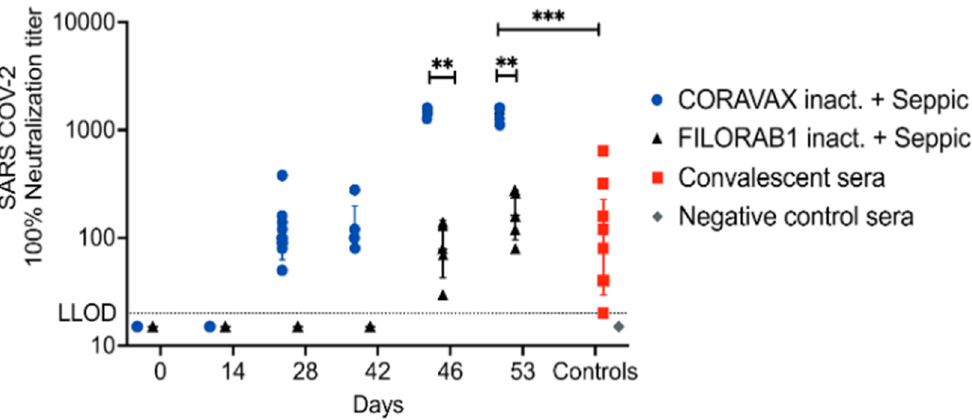
Figure 3. SARS-CoV-2 virus-neutralizing antibody responses. Serum samples collected from each hamster were evaluated for SARS-CoV-2 S-specific virus-neutralizing antibody (VNA) responses using 100 PFU of SARS-CoV-2 isolate USA_WA1/2020.100%. VNA titers are depicted for hamster sera at different time points along with convalescent sera ( n = 7) and negative control sera ( n = 7). The groups are depicted with the following symbols: CORAVAX group in blue circles, FILORAB1 control group in black triangles, convalescent sera in red squares, and negative control sera in grey diamonds. Mean titers ± SD are depicted for each group per time point, and p values were determined by Mann–Whitney test. Only significant differences are depicted. p values are defined as: p > 0.123 (ns), p < 0.033 (*), p < 0.002 (**), p < 0.001 (***). LLOD stands for lower limit of detection.